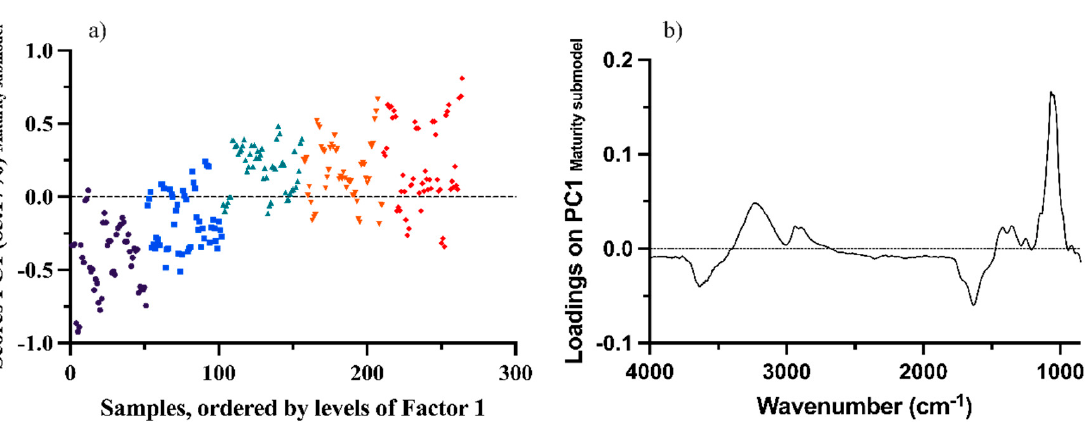
Figure 3. Score ( a ) and loading ( b ) plots of the first factor of the maturity factor submodel. Different colors mean that samples belong to different times (Black—Time 1; Blue—Time 2; Green—Time 3; Orange—Time 4; Red—Time 5).